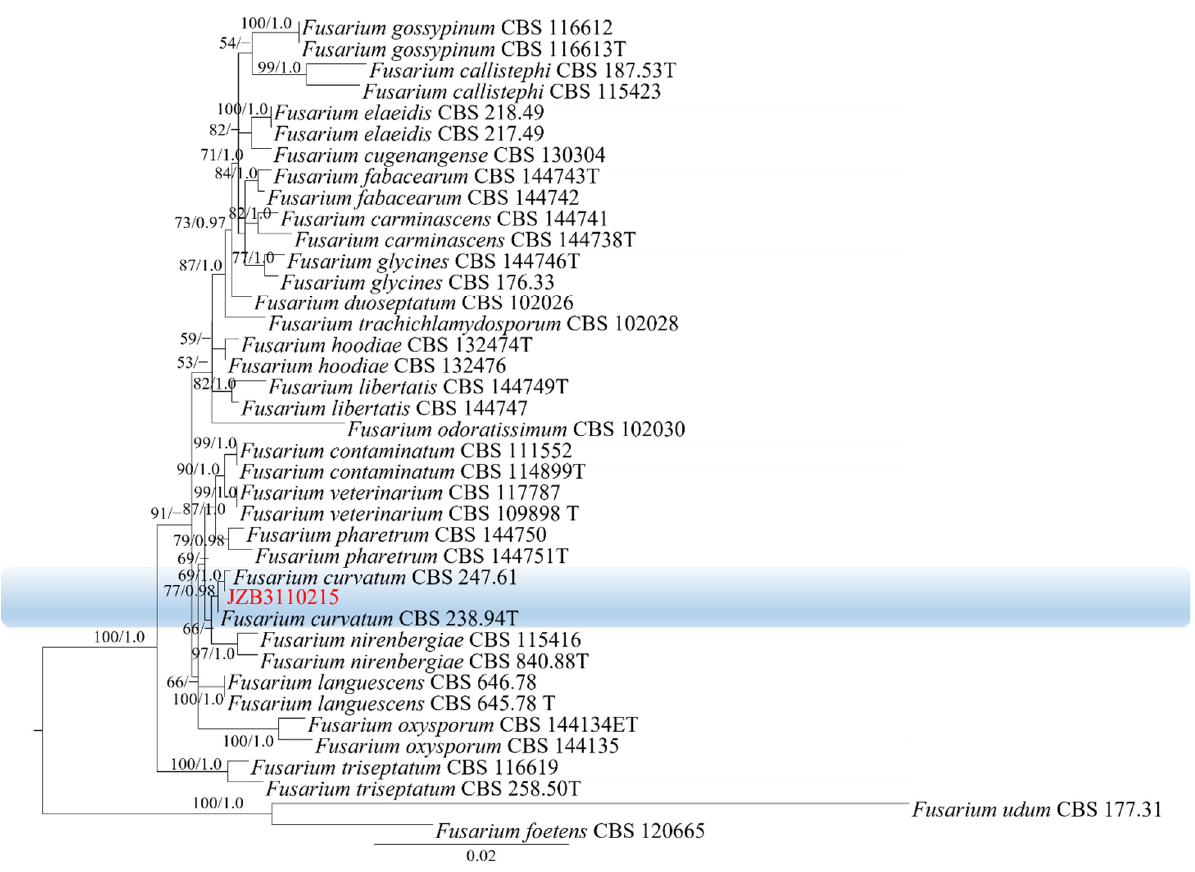
Figure 5. Phylogenetic tree generated by maximum likelihood analysis (RAxML) of FOSC based on the combined rpb2 , tef1 and tub2 sequence data. The tree is rooted with Fusarium foetens (CBS 120665) and Fusarium udum (CBS 177.31). The best-scoring RAxML tree with a final likelihood value of − 4987.801452 is presented. The matrix had 199 distinct alignment patterns, with 0.90% of undeter- mined characters or gaps. Estimated base frequencies were as follows: A = 0.251044, C = 0.269288, G = 0.238899, T = 0.240769; substitution rates AC = 1.155437, AG = 2.887244, AT = 0.424595, CG = 0.728892, CT = 5.651969, GT = 1.000000; gamma distribution shape parameter α = 1.022063. ML bootstrap support values ≥ 50% and Bayesian posterior probabilities (BYPP) ≥ 0.95 are given near the nodes. The scale bar indicates 0.02 changes per site. Isolates belonging to this study are given in red.